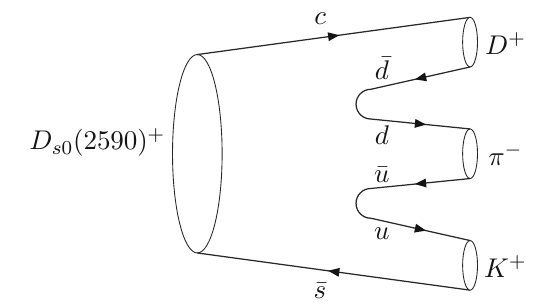
Fig. 1 The detected channel D s 0 ( 2590 ) + → D + K + π − by LHCb